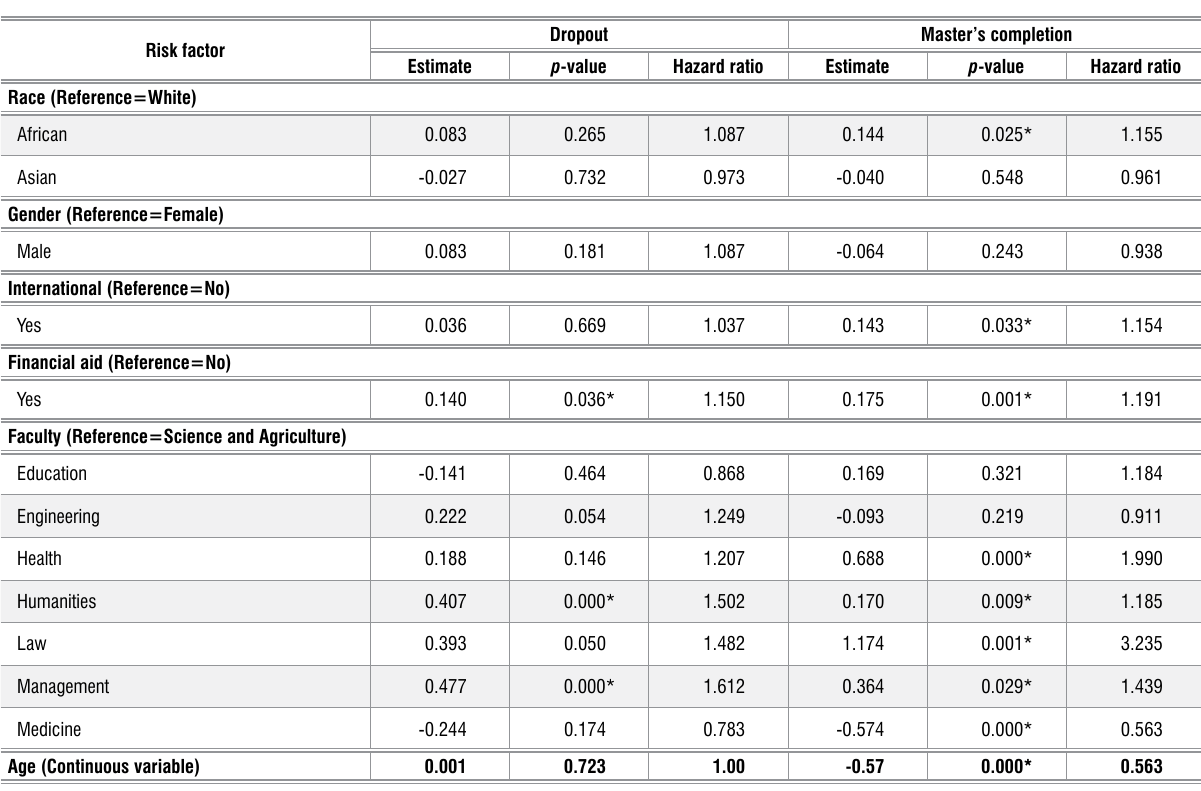
Figure 7: Age-specific cumulative hazard functions at the reference values for master’s students who (a) graduated or (b) dropped out of study at the University of KwaZulu-Natal. Table 2: Results of the competing risk survival model fit for master’s students who received some form of financial